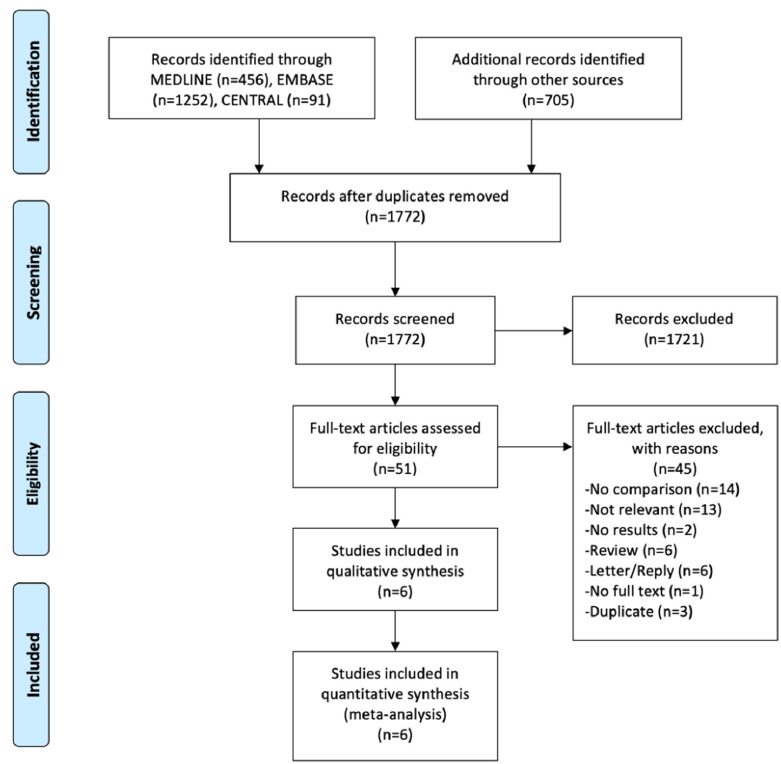
Figure 1. PRISMA flow chart.